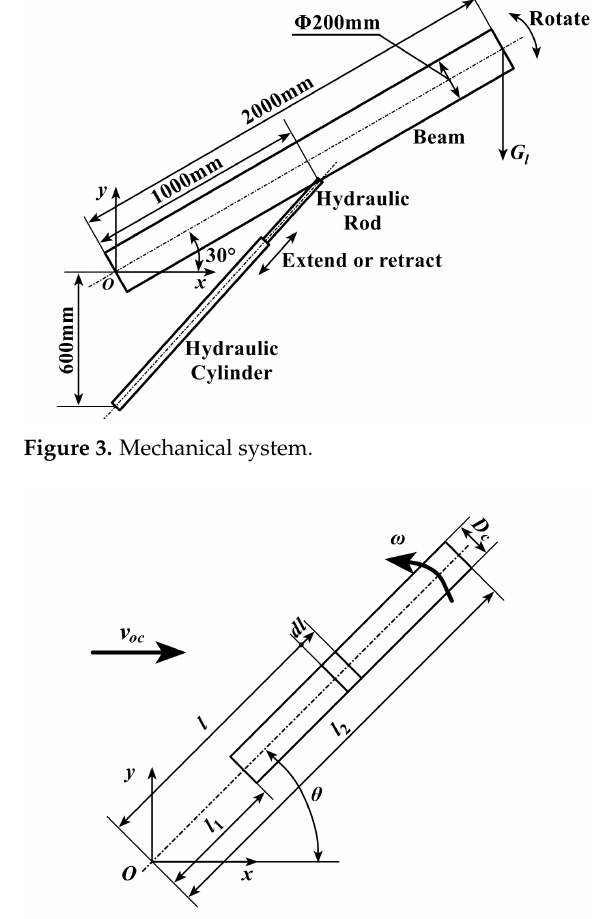
Figure 4. Cylinder rotates in ocean